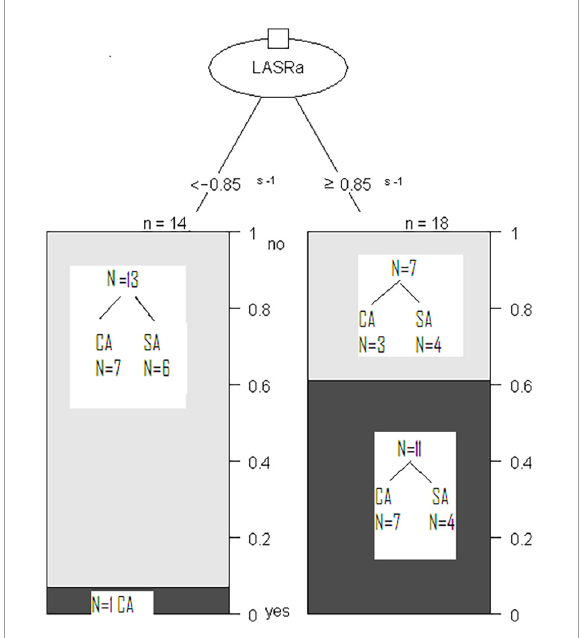
FIGURE4 Classification Tree Model to predict arrhythmia elimination with repeated procedures (CA or SA) based on LA contractile function as determined by LASRa l . Patients with non-recurrence of AF are represented by gray bars (Top) and those with recurrence of AF by black bars